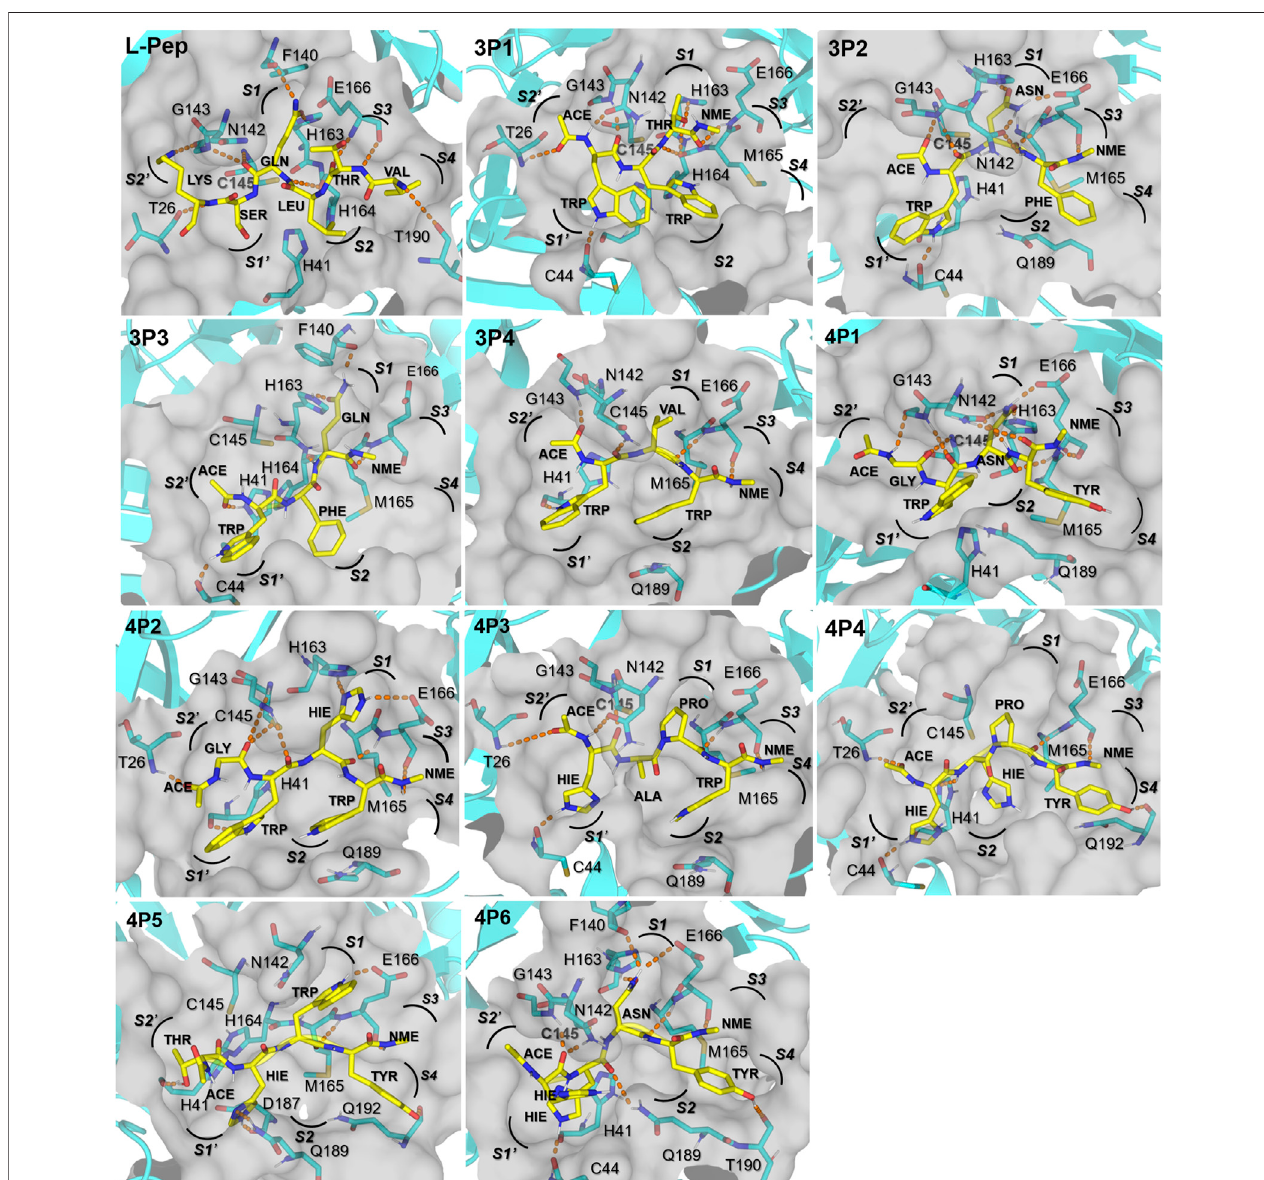
FIGURE 4 | Structural representation of top-ranked D-tripeptides and D-tetrapeptides in complex with 3CL pro . All D-peptides are shown as yellow sticks and their residues are labeled in bold and in the three-letter code. 3CL pro residues forming H-bonds with the peptides plus the catalytic residues H41 and C145 are labeled and represented as cyan sticks. The 3CL pro active site cavity is depicted as a transparent gray surface. H-bonds between the D-peptides and the 3CL pro residues with occupancies > 25% during the respective 110 ns MD simulations are displayed as orange dashed lines. Subsites S4 to S2 ′ are labeled in bold and italic. Structural representations of the remaining D-peptides included in Table 1 can be found in Supplementary Figure S5